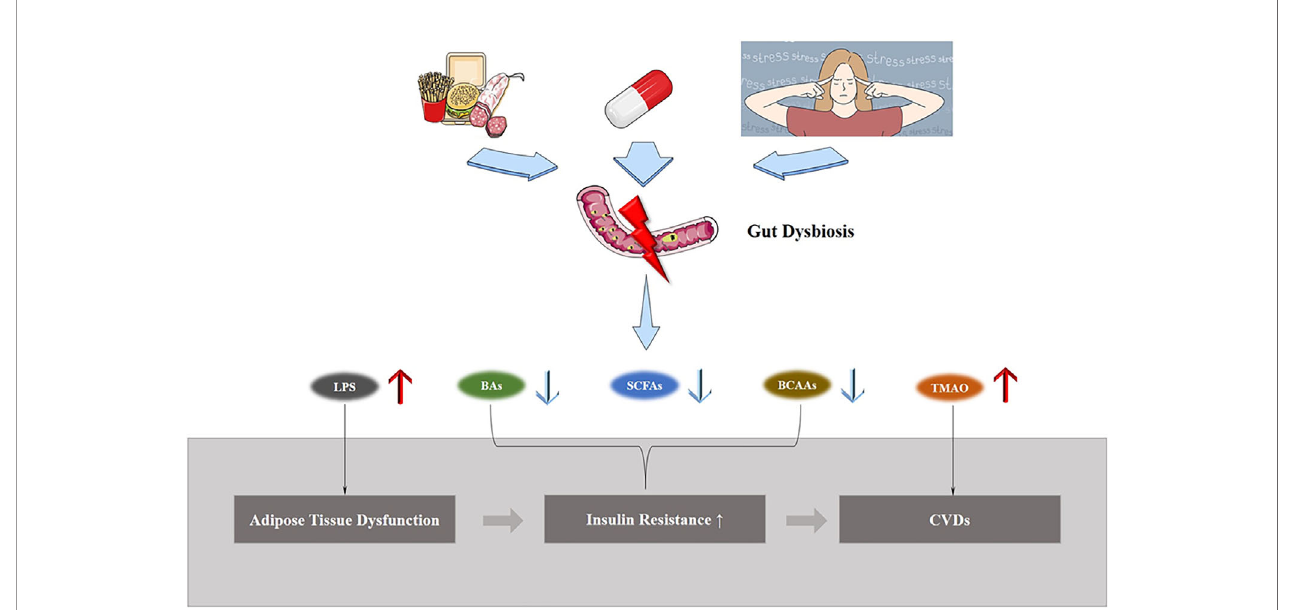
FIGURE 3 | Gut dysbiosis and ATD induced CVDs. Exposure to external environment changes, such as a high-fat diet, treatment with antibiotics, and stress, lead to gut dysbiosis, causing changes in the structure of gut microbiota and metabolite levels, and increases the morbidity of ATD-induced